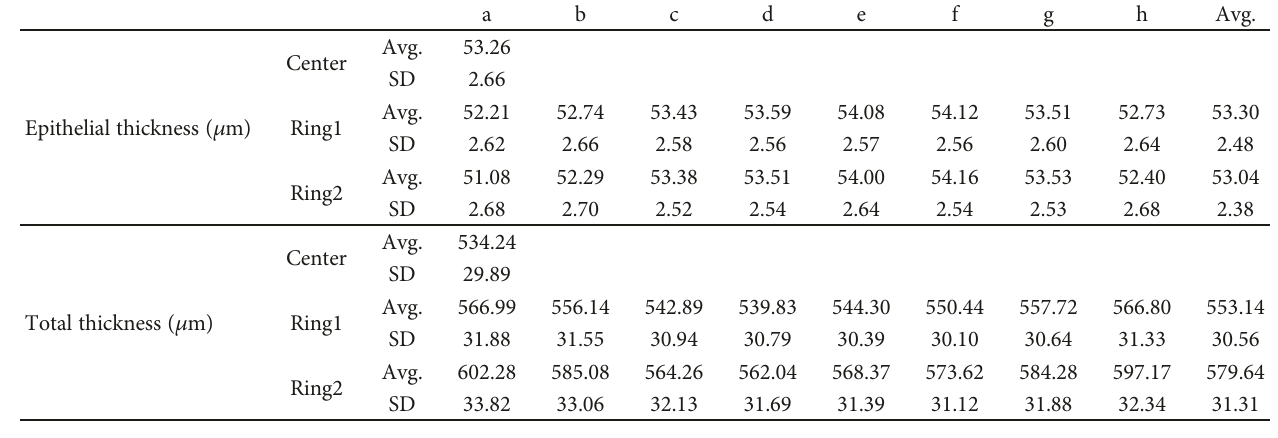
Table 2: The corneal epithelial thickness and corneal thickness in di ff erent locations.